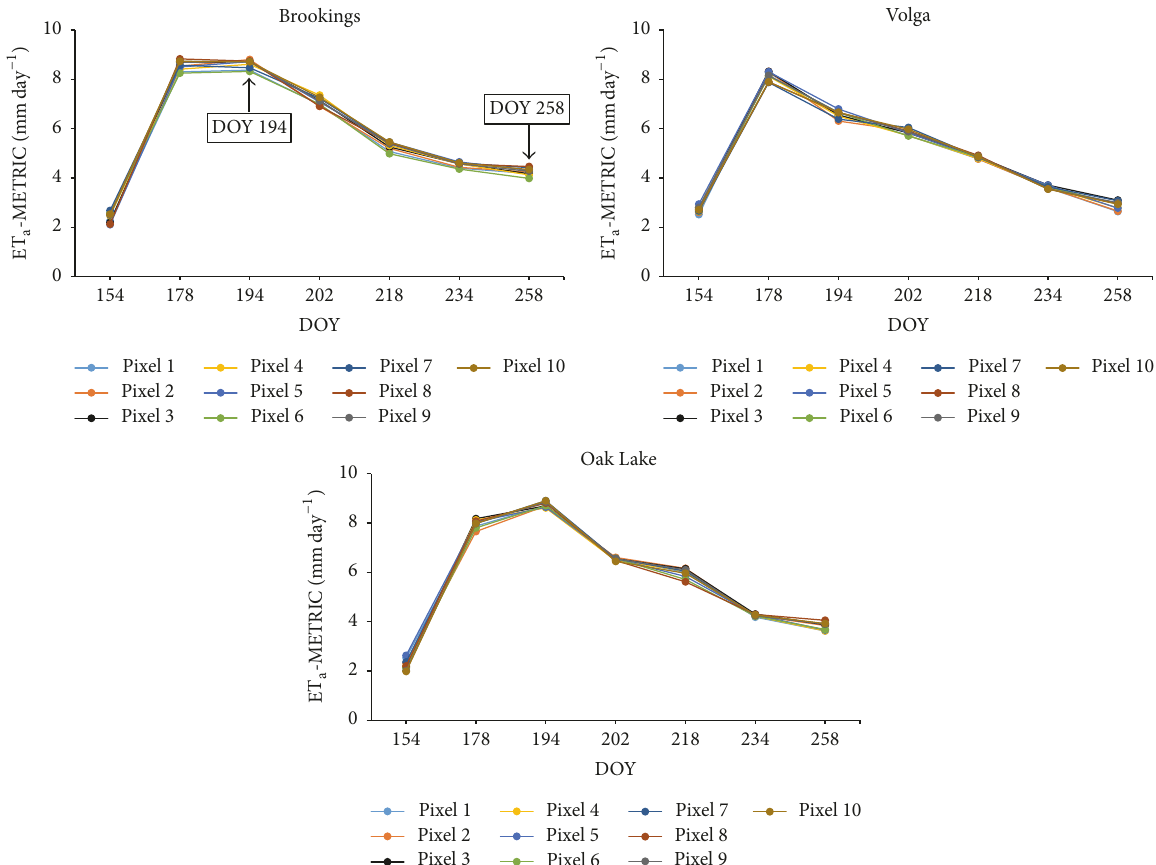
Figure 8: Evolution of ET -METRIC values at three sites in eastern South Dakota. Ten random pixels were selected within a field in each a site. The values from those same pixels were observed during the 2016 growing